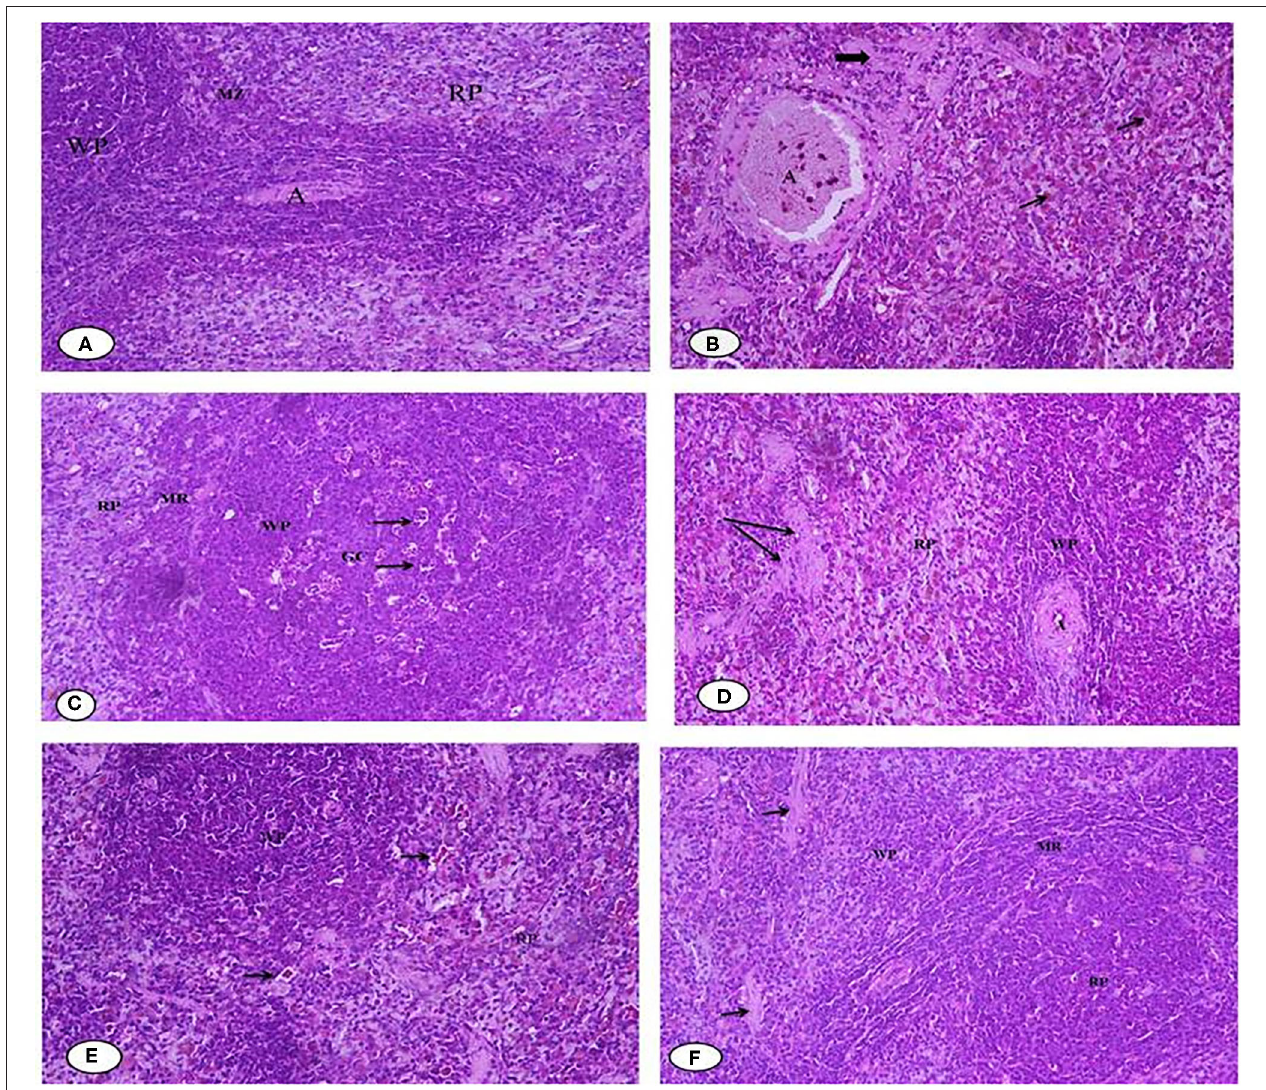
FIGURE 10 | (A–F) Representative photomicrographs of spleen sections of rats from the different experimental groups (Hematoxylin and eosin stain X 40). (A) G1 Negative control. (B) G2 Positive control Group. (C) G3 Fed SFY fortified with free Fe + ascorbic acid. (D) G4 Fed SFY fortified with free Fe + FA + ascorbic acid. (E) G5 Fed SFY fortified with Fe@ BSA-NPs + ascorbic acid. (F) G6 Fed SFY fortified with Fe + FA@ BSA-NPs + ascorbic acid. BSA-NPs, Bovine Serum Albumin nanoparticles; FA, Folic